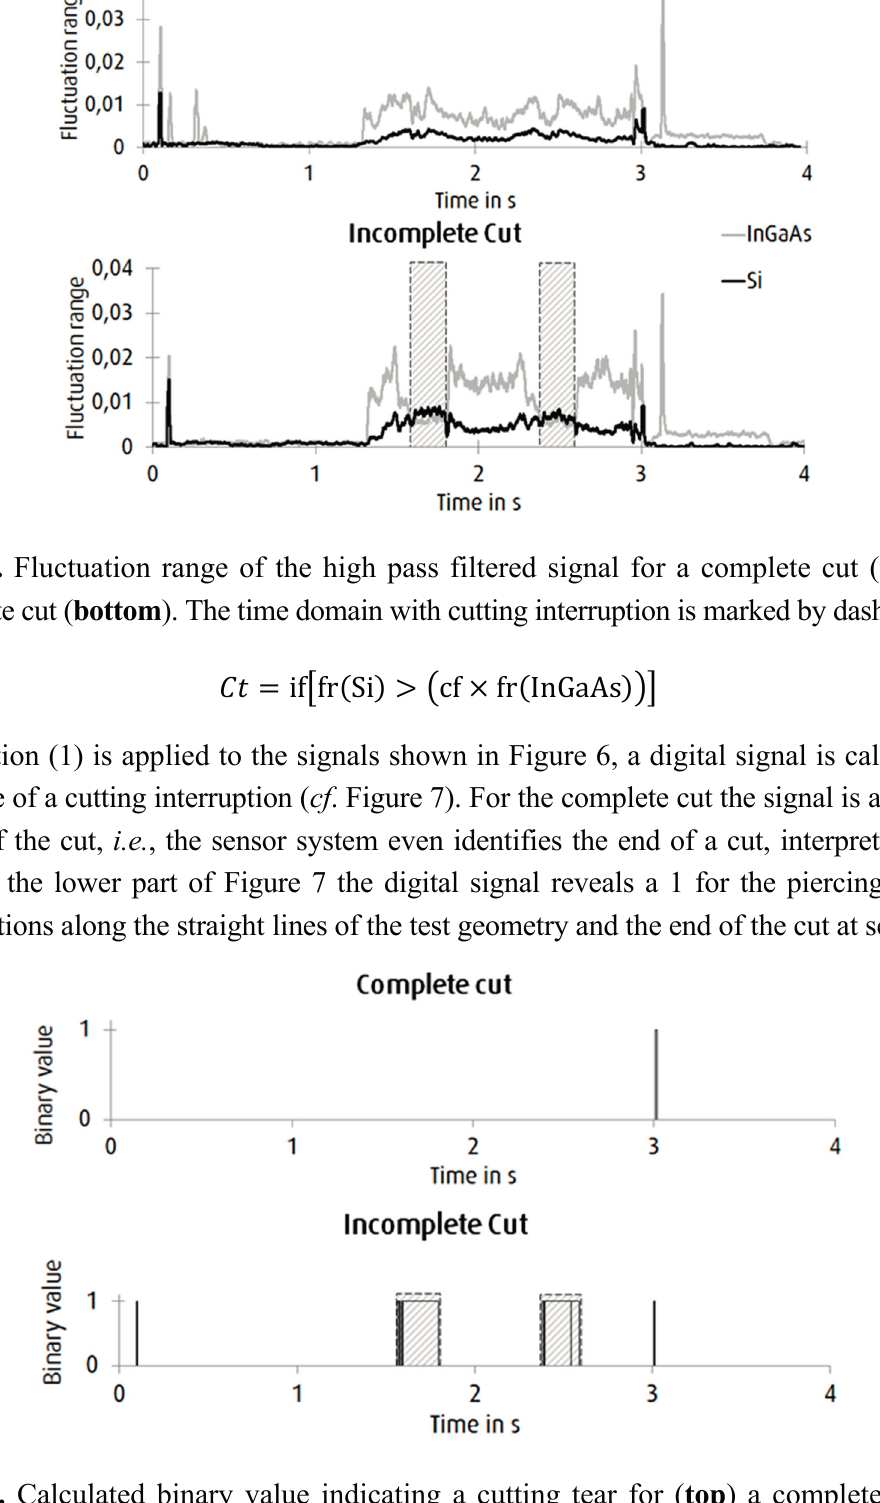
Figure 7. Calculated binary value indicating a cutting tear for ( top ) a complete cut and ( bottom ) an incomplete cut. The time domain with cutting interruption is marked by dashed